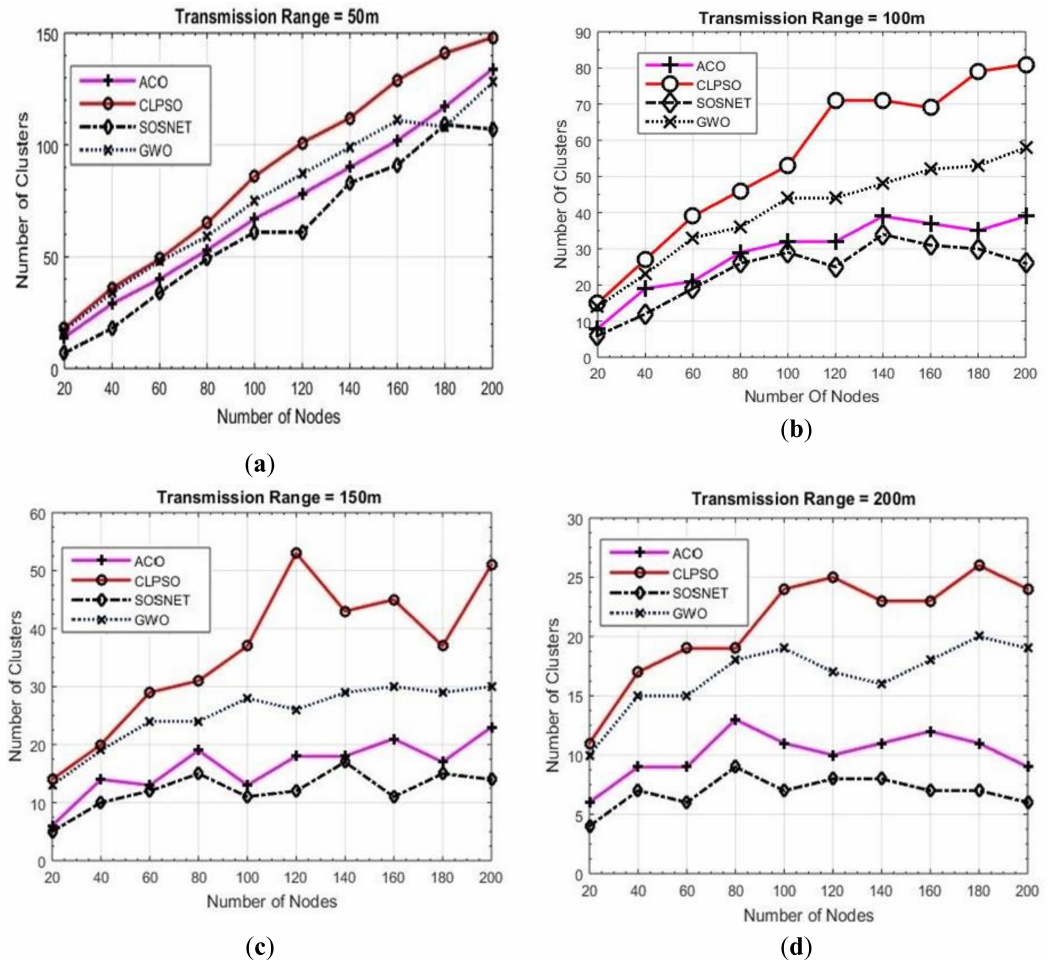
Figure 6. Grid size 1000 m × 1000 m, transmission ranges 50 to